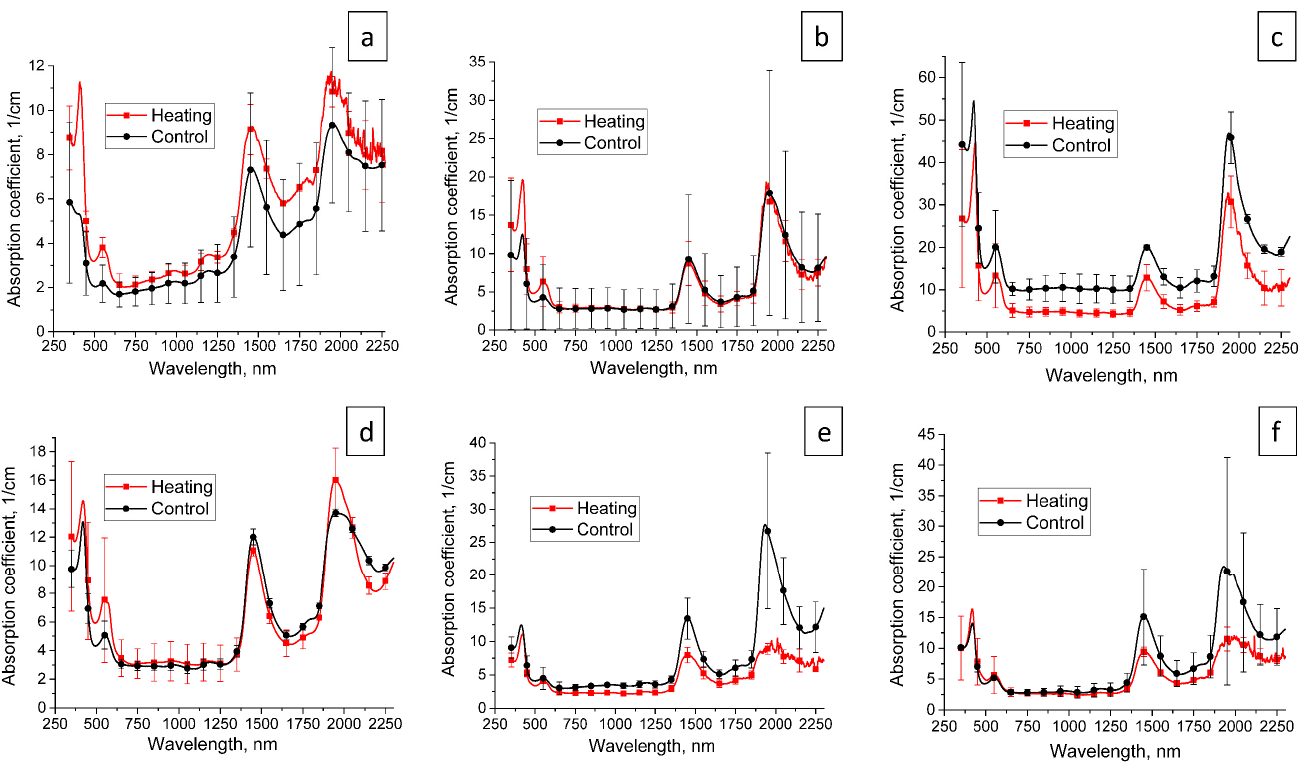
Figure 7. Spectra of the absorption coefficient of tumor and surrounding tissues from experimental and control groups: ( a ) skin, ( b ) sub-skin layer, ( c ) tumor capsule, ( d ) tumor top, ( e ) tumor center, and ( f ) tumor bottom.